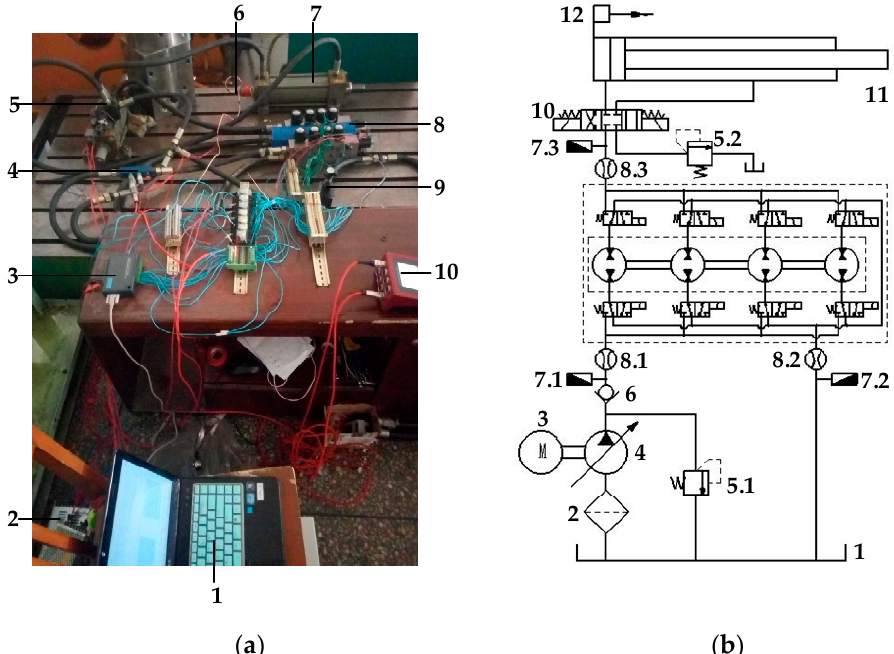
Figure 9. Experimental simulation platform of the hydraulic traction system. ( a ) Physical diagram of the experiment platform. (1) Measurement and control system. (2) Direct current power. (3) Data acquisition card. (4) Flow/pressure sensor. (5) Three-position, four-way solenoid directional valve. (6) Displacement sensor. (7) Hydraulic cylinder. (8) DHT. (9) Relief valve. (10) Flow/pressure gauge; ( b ) Hydraulic schematic of the experimental platform. (1) Tank. (2) Filter. (3) AC motor. (4) Constant-pressure variable displacement pump. (5) Relief valve. (6) Check valve. (7) Pressure sensor. (8) Flow sensor. (9) DHT. (10) Three-position, four-way solenoid directional valve. (11) Hydraulic cylinder. (12) Displacement sensor.